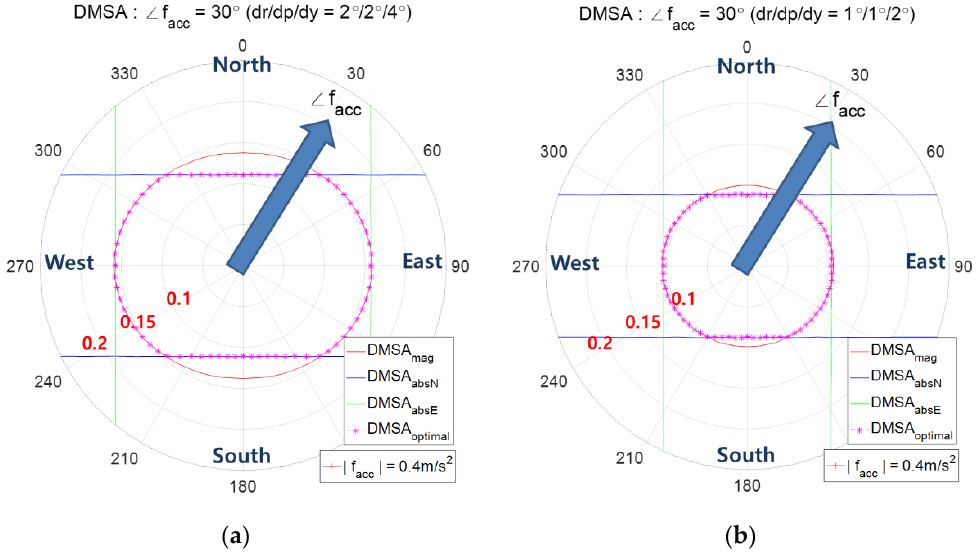
Figure 15. Combined Contour of DMSA with respect to the AHRS attitude accuracy.